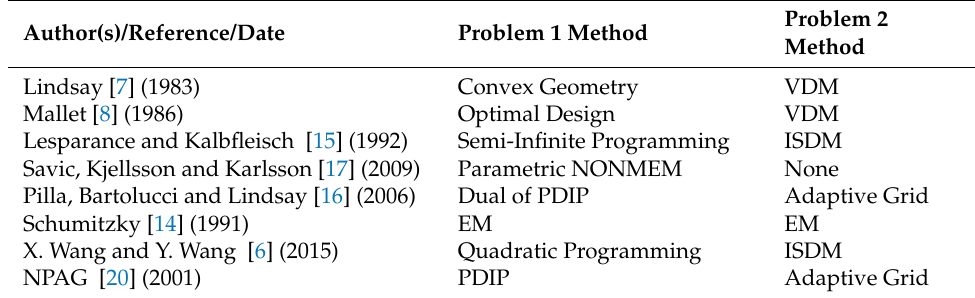
Table 1. Table of NPML